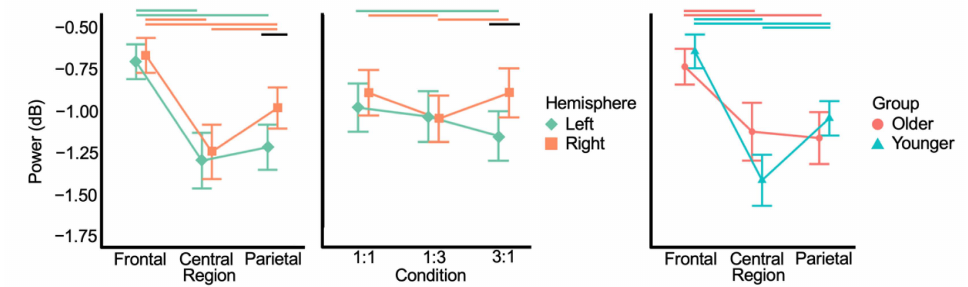
Figure 5. Interaction plots for movement-related beta desynchronization (MRBD) during motor planning. Lower power values represent more MRBD. In line with Hypothesis 3, MRBD was more prevalent in the left hemisphere. Notably, no hemisphere × group effect was present, contrary to Hypothesis 4. Error bars denote the 95% confidence interval, horizontal lines denote significant post- hoc contrasts with colors indicating within hemisphere/group differences and black lines indicating hemisphere / group